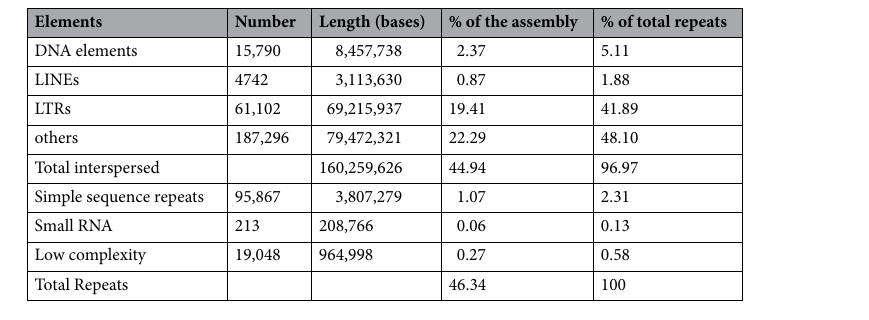
Table 4. Summary of repeat elements identified in A. occidentale genome.